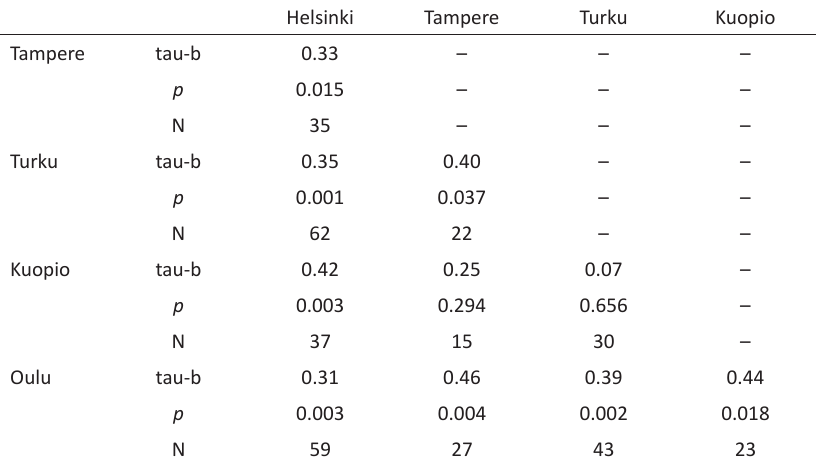
Table 3. Kendall’s tau-b correlations of maximum scores in common garden experiments among